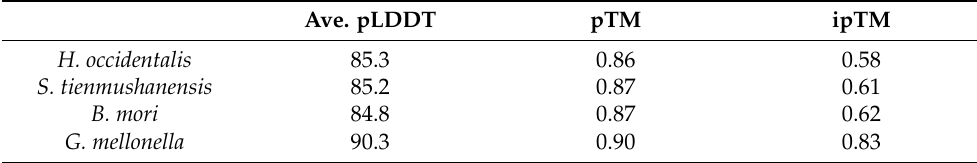
Table 1. Alphafold-multimer